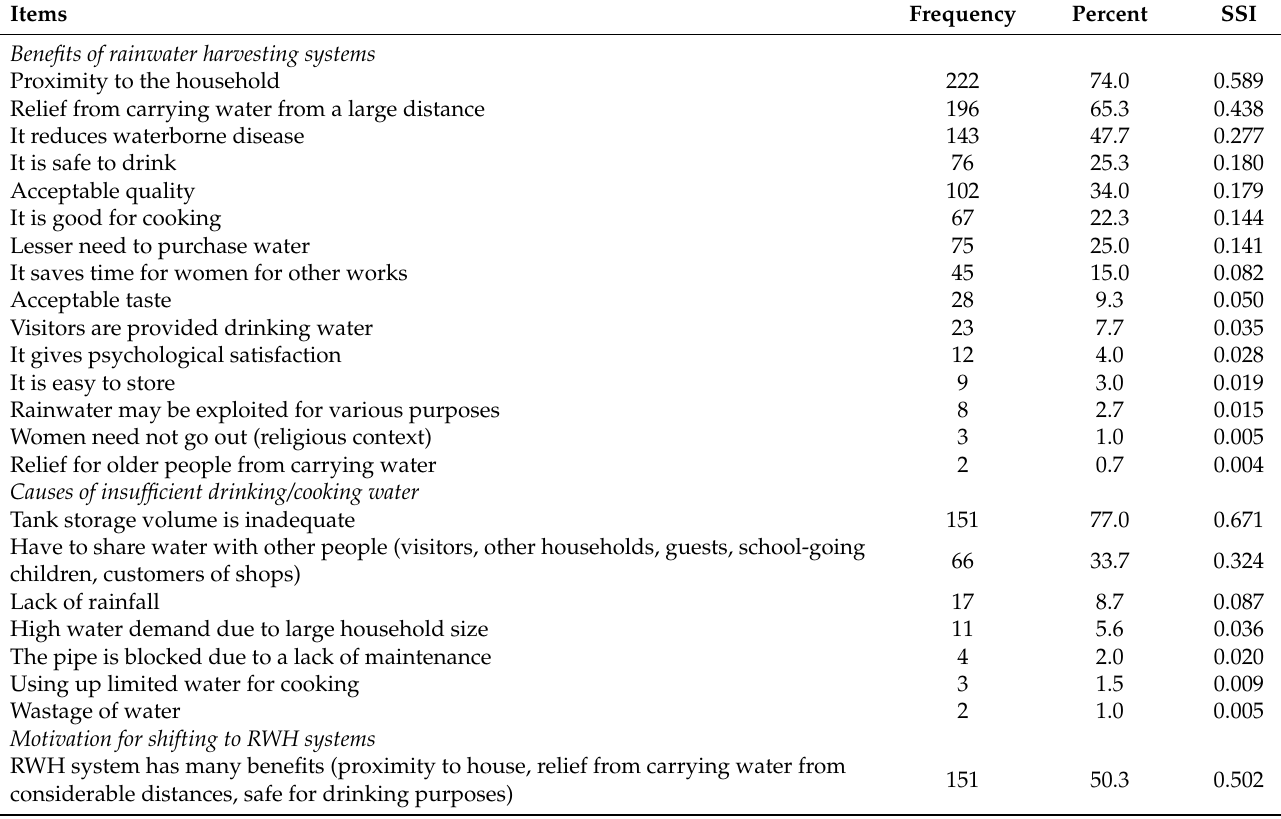
Table 7. Free listing results by